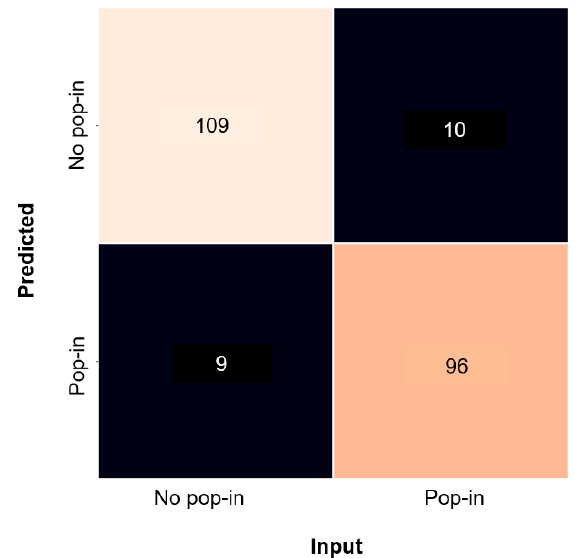
Figure 7. Confusion matrix obtained from the validation dataset tested in the CNN model.